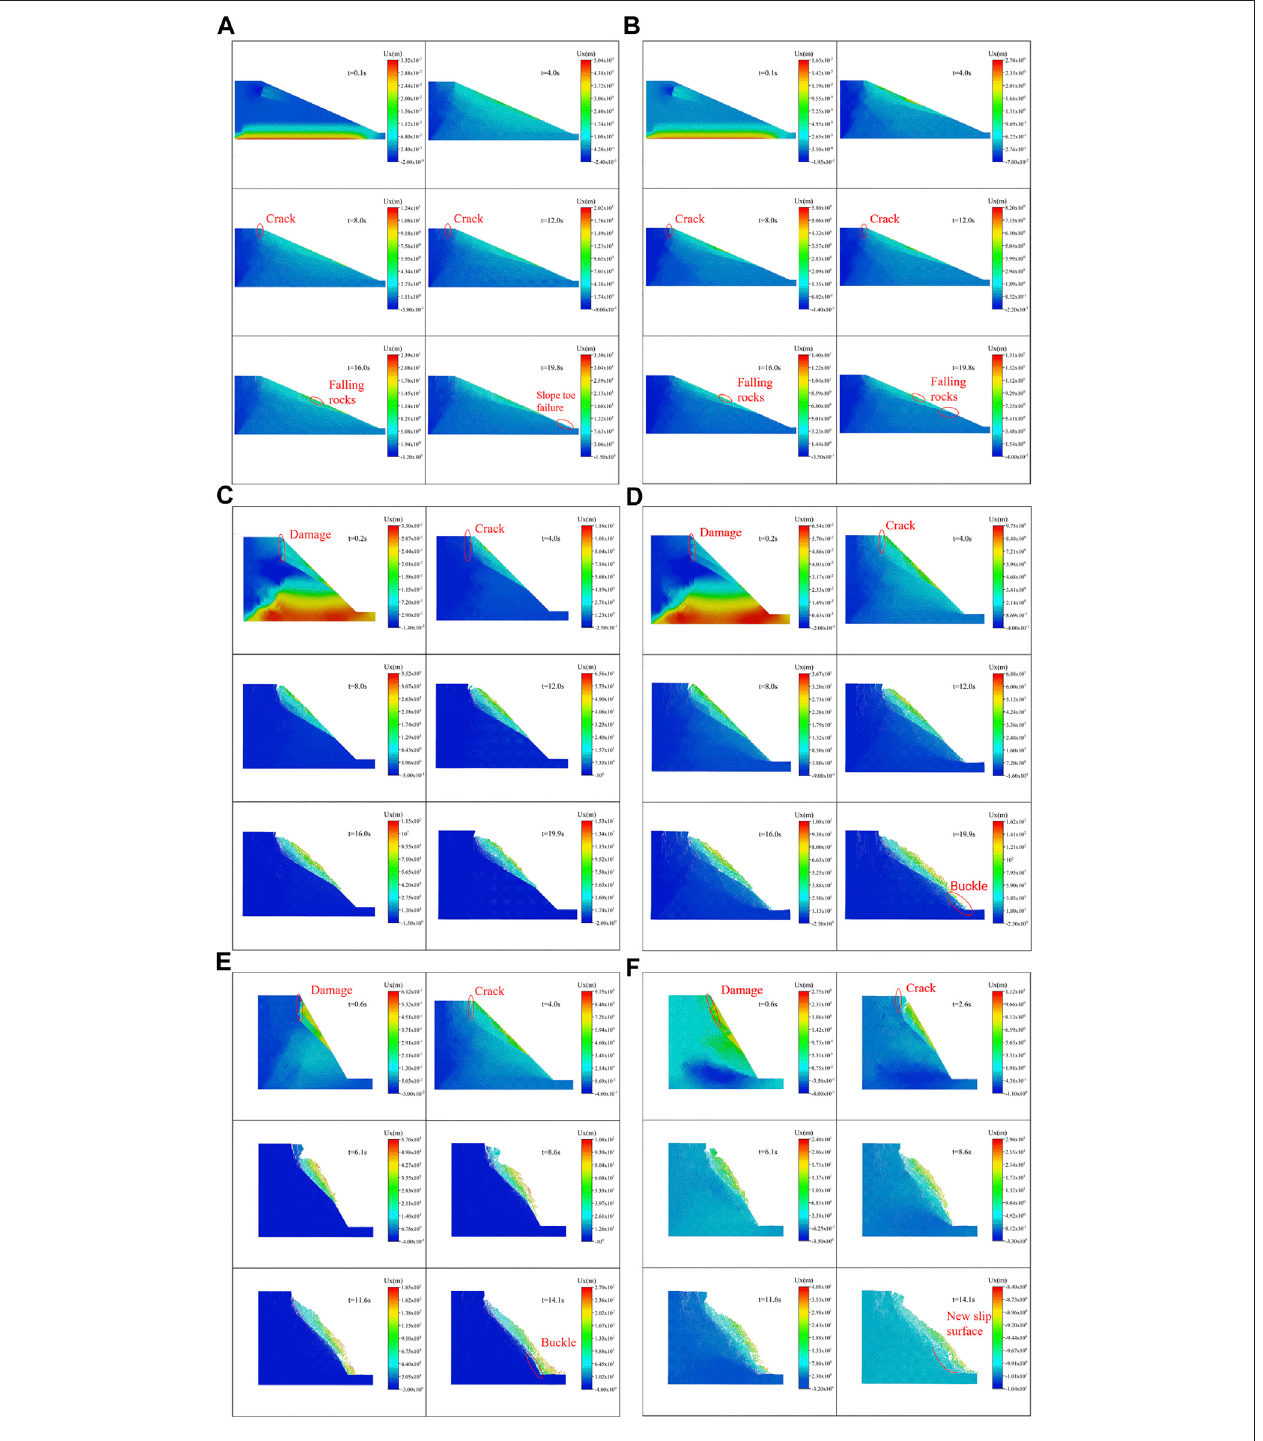
FIGURE 8 | The failure process of the slope (A) 0.5 g-15 ° , (B) 1.0 g-15 ° , (C) 0.5 g-30 ° , (D) 1.0 g-30 ° , (E) 0.5 g-45 ° , (F) 1.0 g-45 ° .